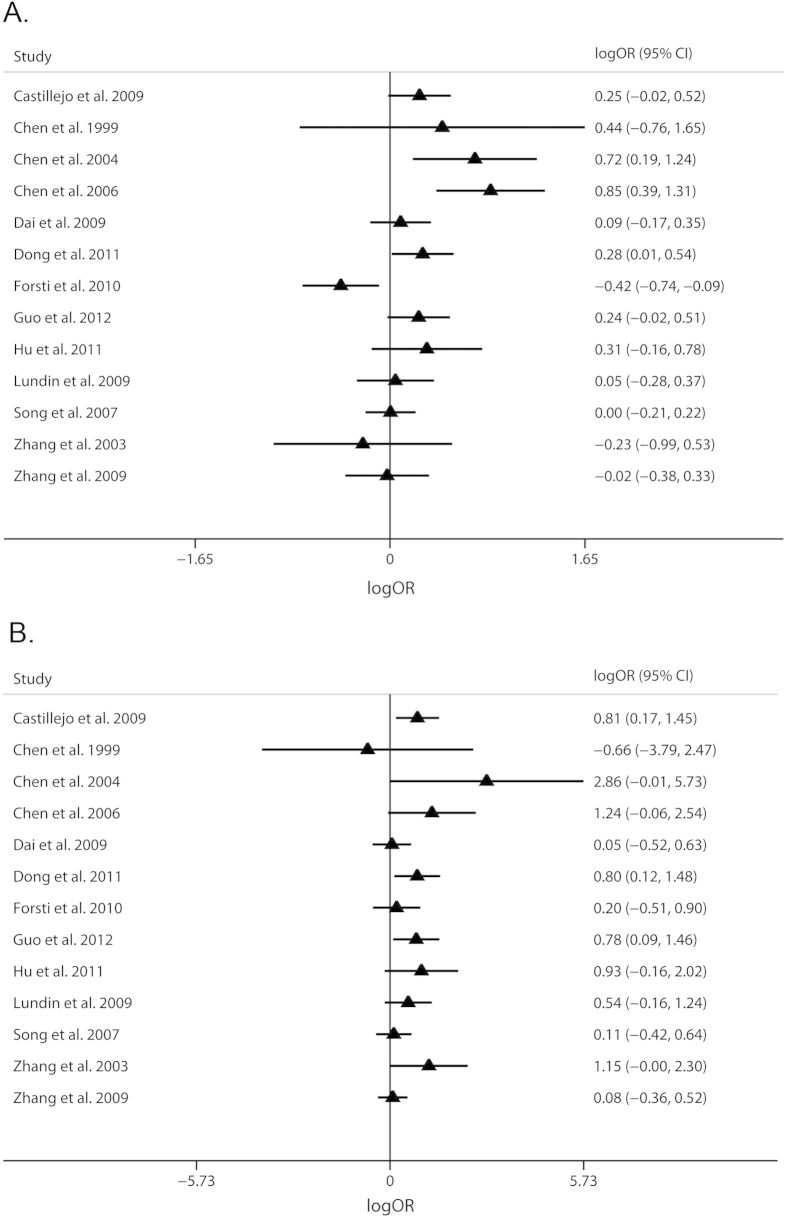
Plots of the study-specific estimates and 95% CIs of the two
parameters, A) for θ2; B) for
θ3. θ2 is
the logarithmic scale of ORGA/GG and
θ3 is the logarithmic scale of
ORAA/GG derived from logistic regression. The triangles and
horizontal lines correspond to the study-specific estimates and 95% CIs.